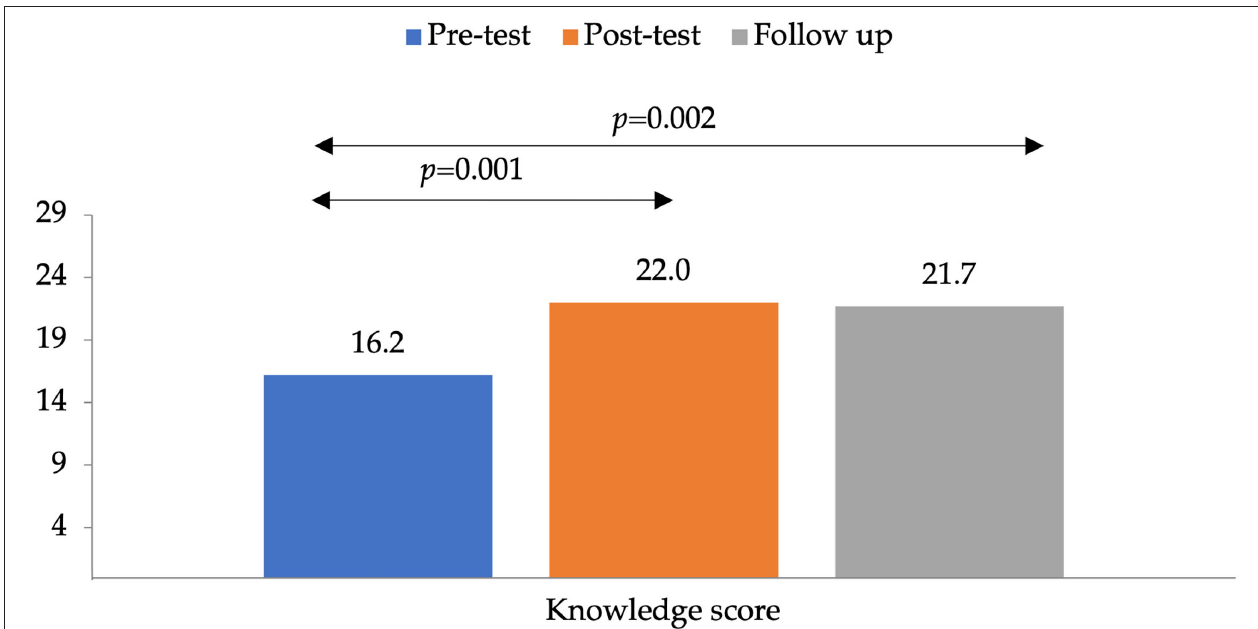
FIGURE 2 | Mean knowledge scores of pre-test, post-test, and follow up. The p -value indicates the statistical significance of the paired sample t -test.